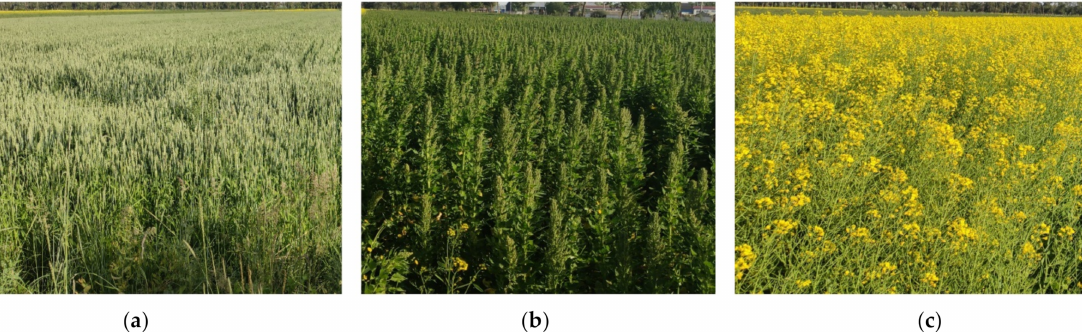
Figure 2. Field photograph: ( a ) wheat; ( b ) quinoa; and ( c ) rapeseed. Field photographs show wheat, quinoa, and rape as the three main crops studied.